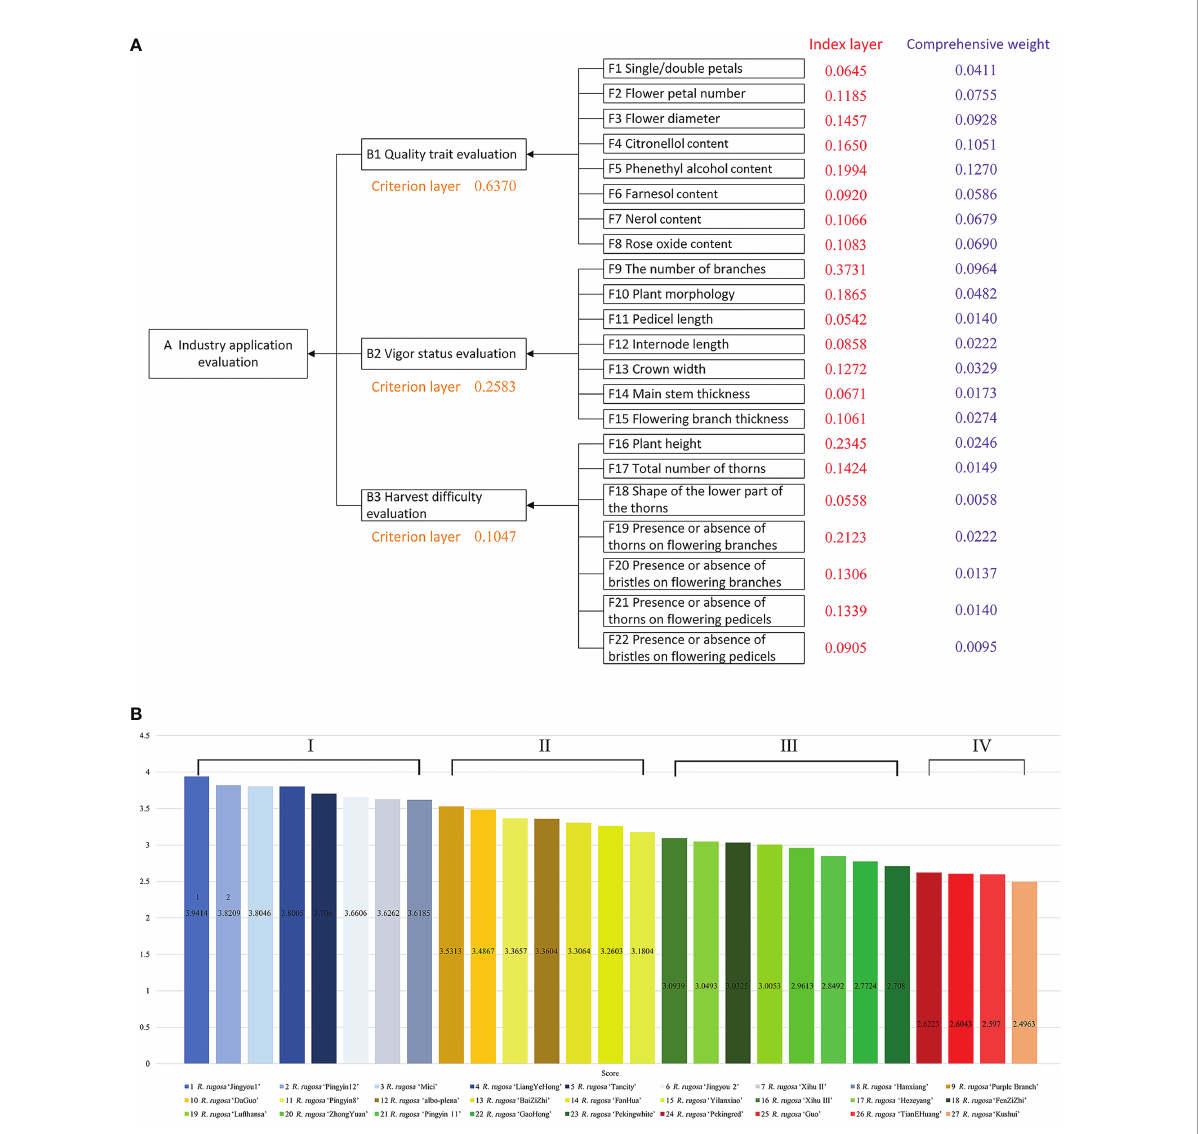
FIGURE 3 Analytic hierarchy process (AHP) model constructed for R. rugosa cultivars and the fi nal scores. (A) AHP model constructed for R. rugosa cultivars. The orange numbers are values of the criterion layer (B1, B2, and B3). The red numbers are values for the index layer (F1 – F22). The violet numbers are values for the comprehensive weight. (B) The fi nal scores of 27 R. rugosa